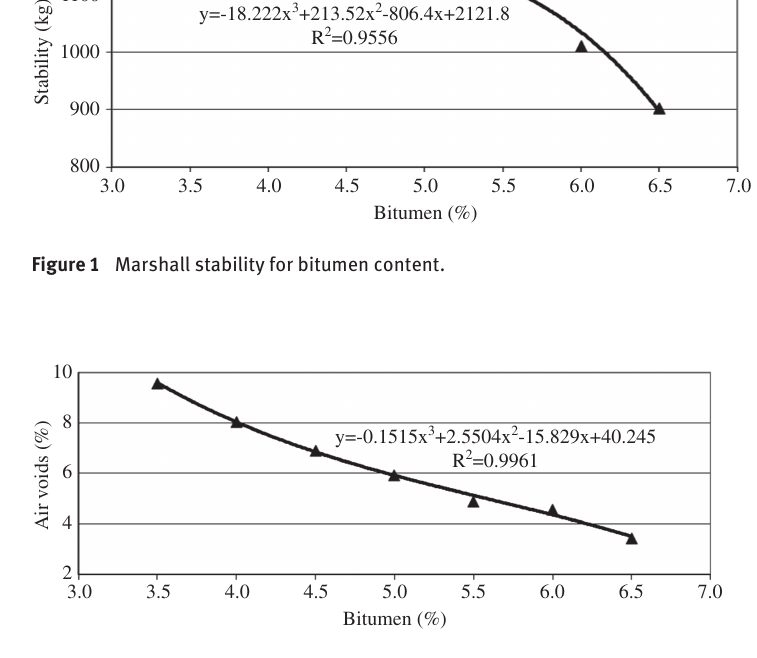
Figure 2 Relationship between air voids and bitumen content.